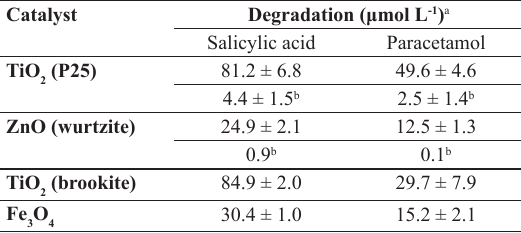
Table 1. Photodegradation of salicylic acid and